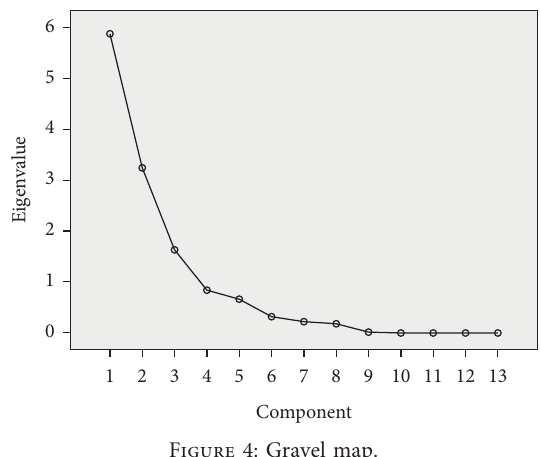
Figure 4: Gravel map.